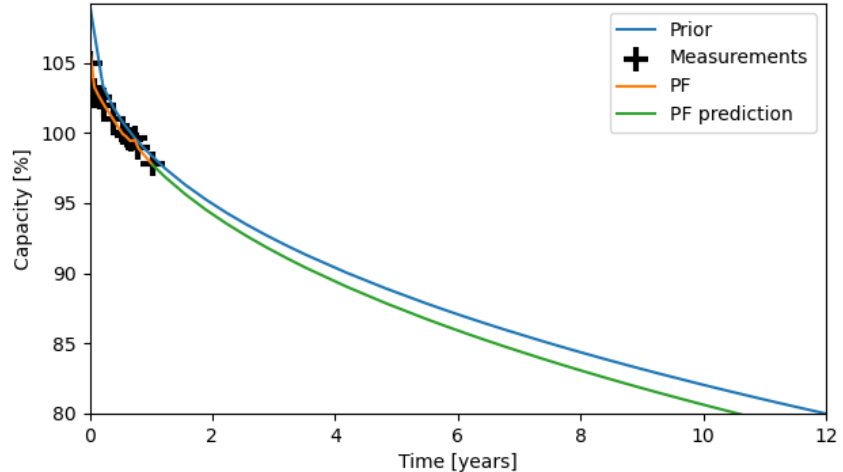
Figure 6. Aging evolution and recorded SOH estimations of the sized battery system for the electric bus.